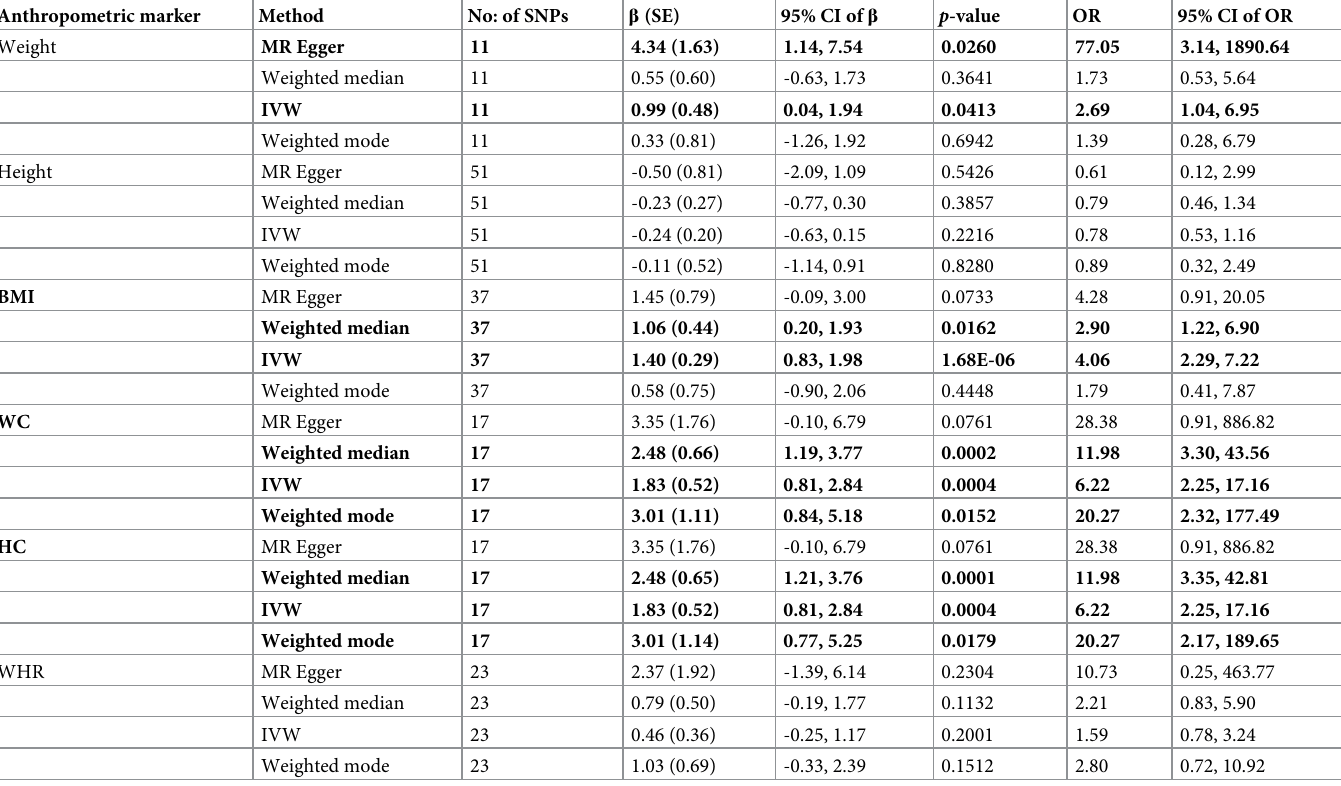
Table 2. Results from two-sample Mendelian randomization analyses on the causality of anthropometric markers associated with polycystic ovarian syndrome. Anthropometric marker